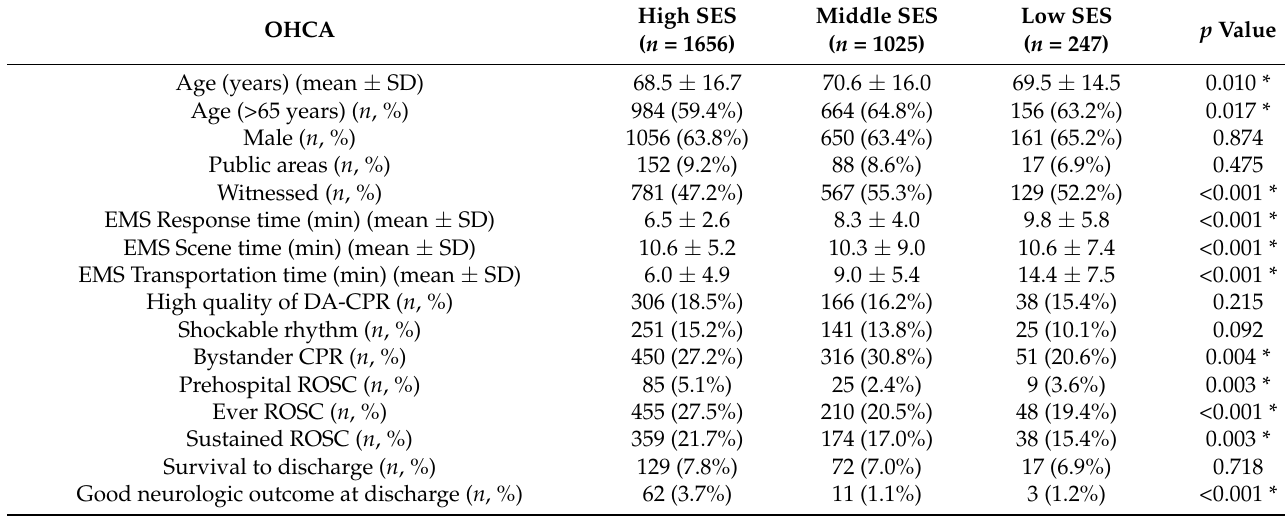
Table 1. Characteristics in patients with out-of-hospital cardiac arrest by community socioeconomic status.